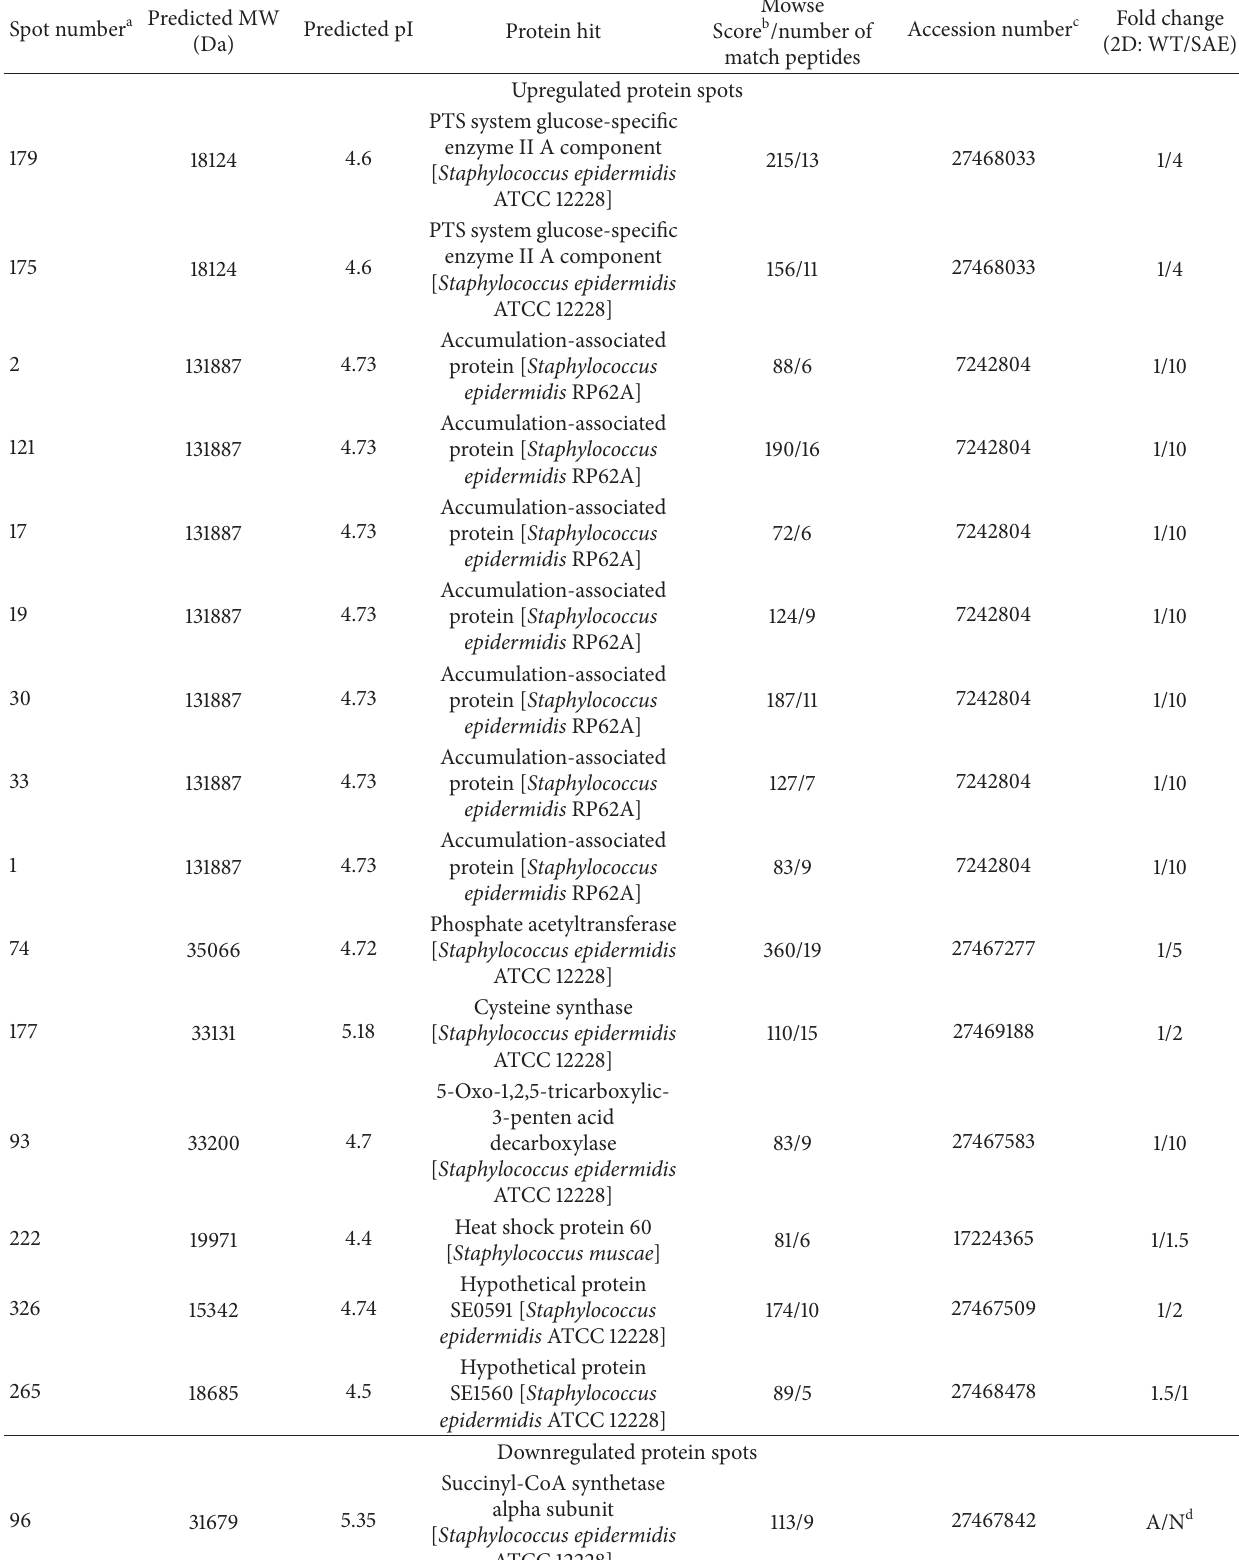
Table 2: Protein expression regulated by saeRS in S. epidermidis